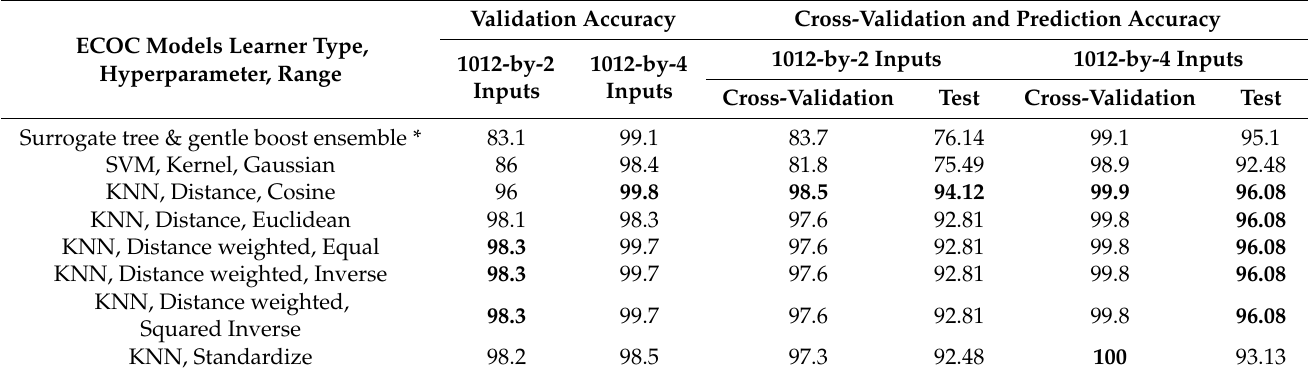
Table 6. ECOC classification results with different learner types, hyperparameters, and ranges.